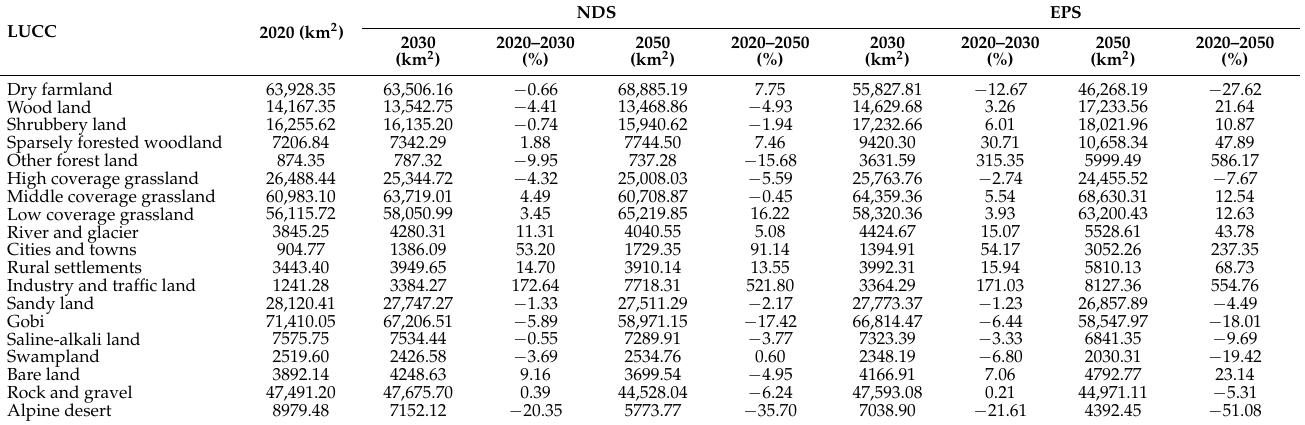
Table 5. Area of LUCC in the Gansu province in 2030 and 2050 under the NDS and EPS scenarios.